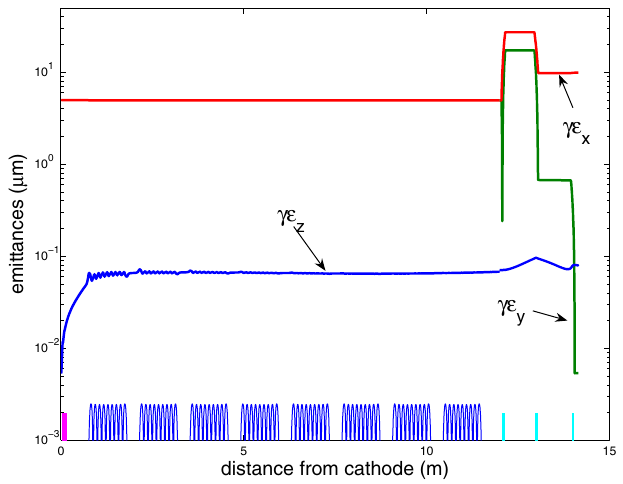
FIG. 3. (Color) Evolution of the transverse horizontal (red), vertical (green), and longitudinal (blue) emittances along the photoinjector beam line. The purple and cyan boxes at the bottom indicate the locations of the rf gun and the skew quadru- poles, respectively, while the blue lines indicate the accelerating cavity